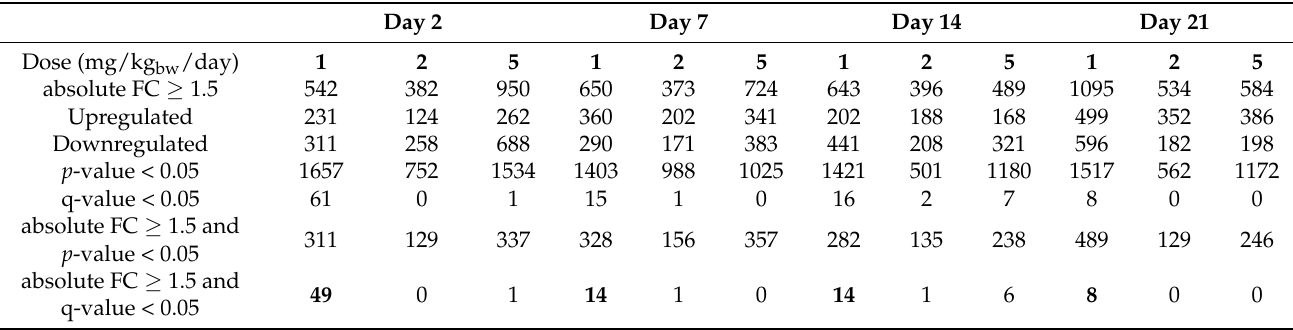
Table 2. DEGs after LIMMA analysis of the microarray data obtained from Tg mice exposed to E171 at 1, 2, and 5 mg/kg bw /day, including absolute FC, the number of up- and downregulated genes, p -value, and q-value, as well as a combination of absolute FC and p /q-values. The DEGs in bold (absolute FC ≥ 1.5 and q-value < 0.05) were used for ORA pathway